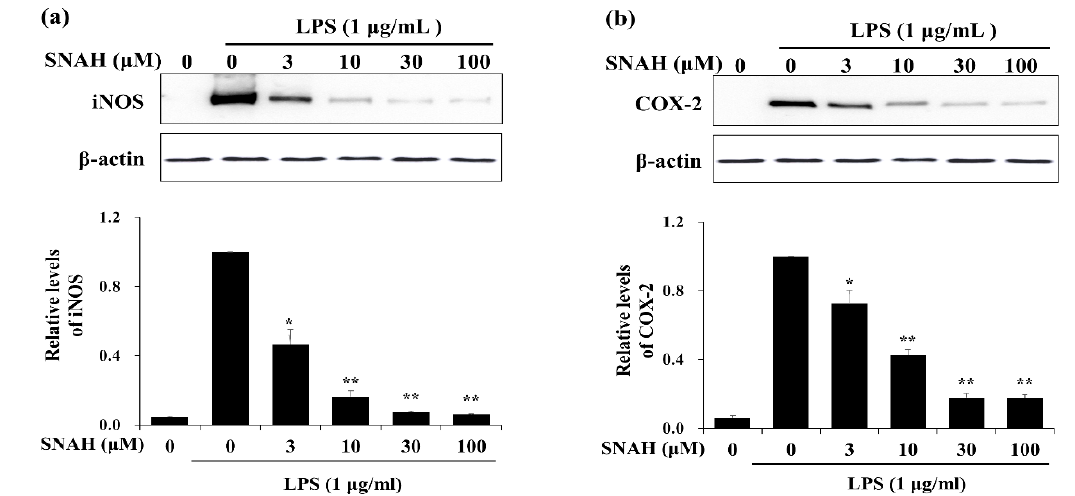
Figure 3. E ff ects of SNAH on LPS-induced iNOS and COX-2 protein expression. RAW 264.7 Cells were